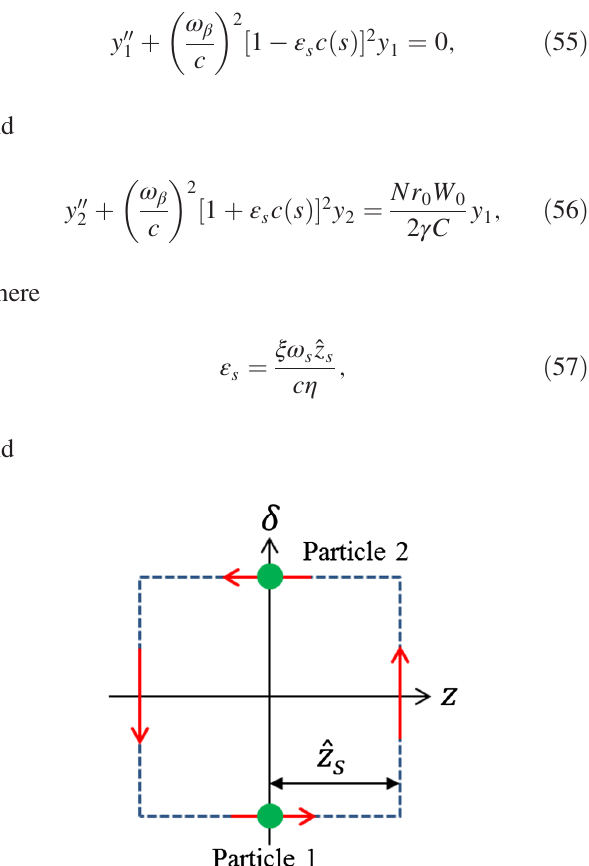
as a FIG. 5. The particle motion in the square well potential above s the